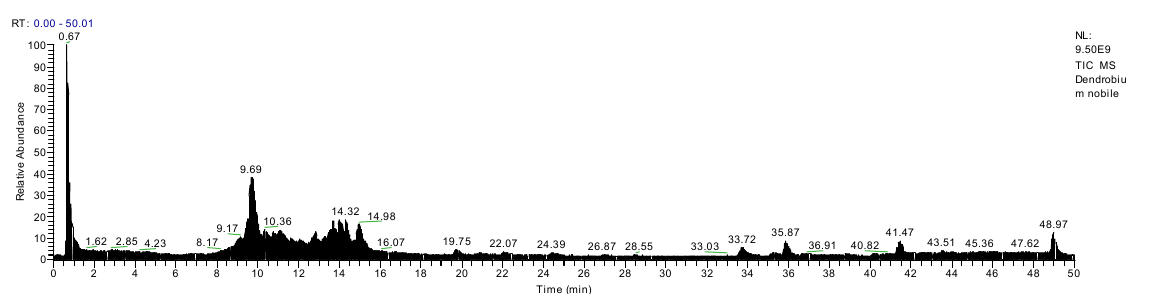
Figure 1. TIC chromatogram of D. nobile extract by UPLC-ESI-Q-Orbitrap.